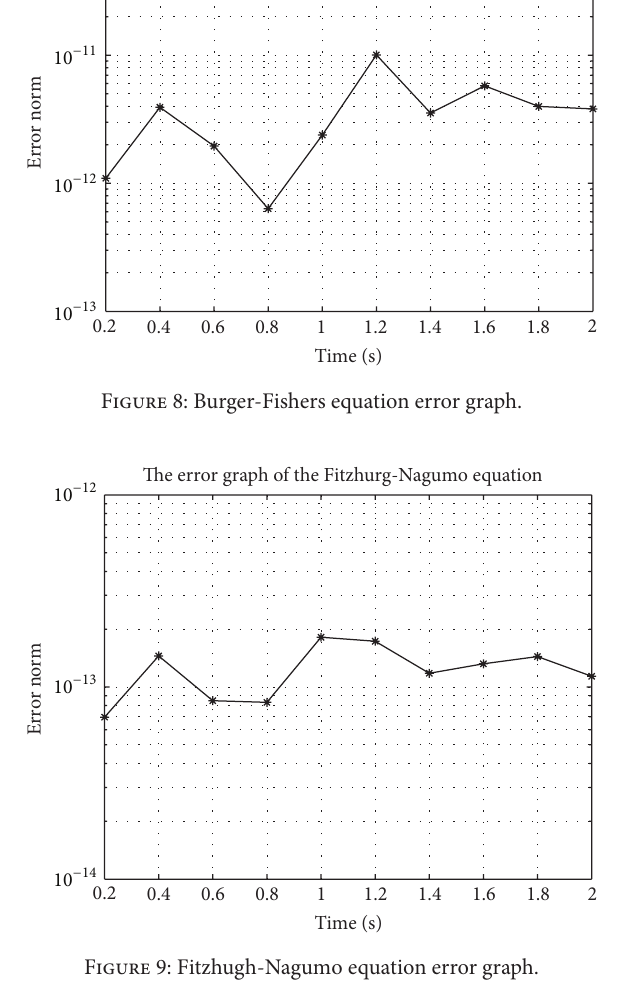
Figure 12: Modified KdV equation error